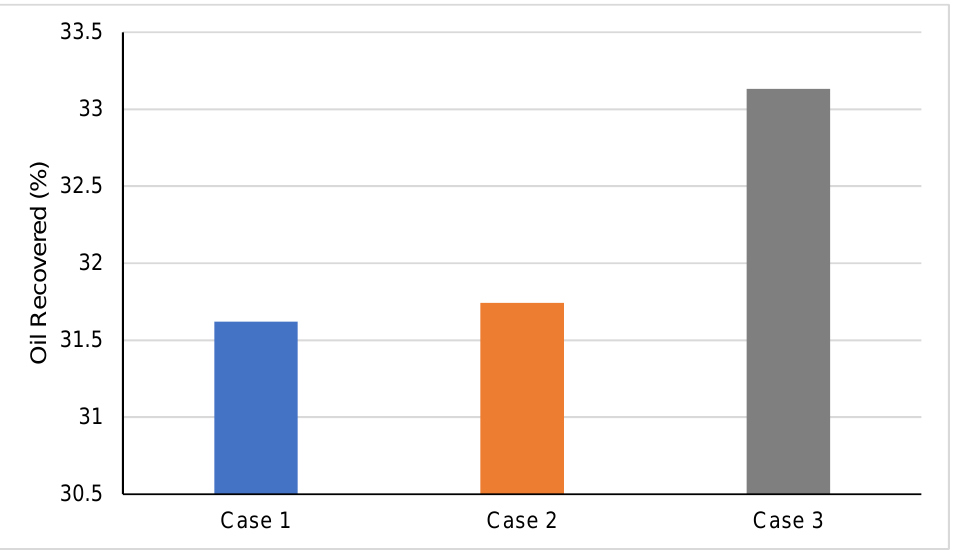
Figure 15. Oil recovered as a percentage of OOIP.